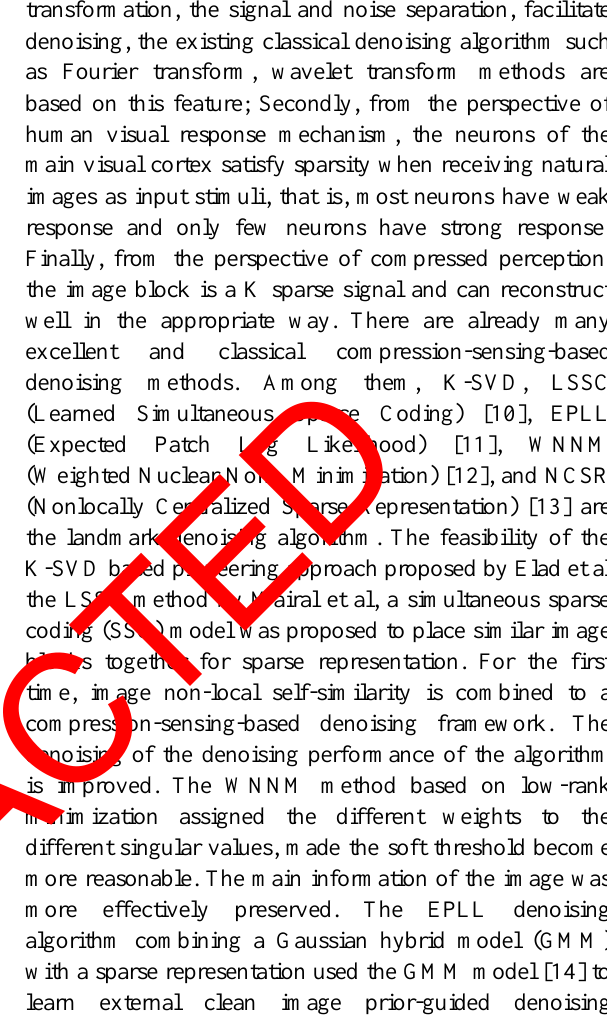
algorithm combining a Gaussian hybrid model